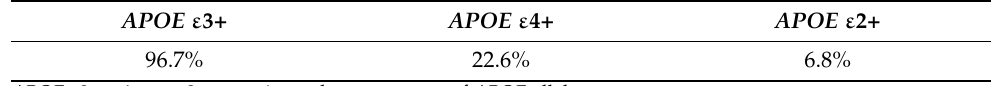
Table 2. The distributions of APOE alleles in the studied Hispanic population.